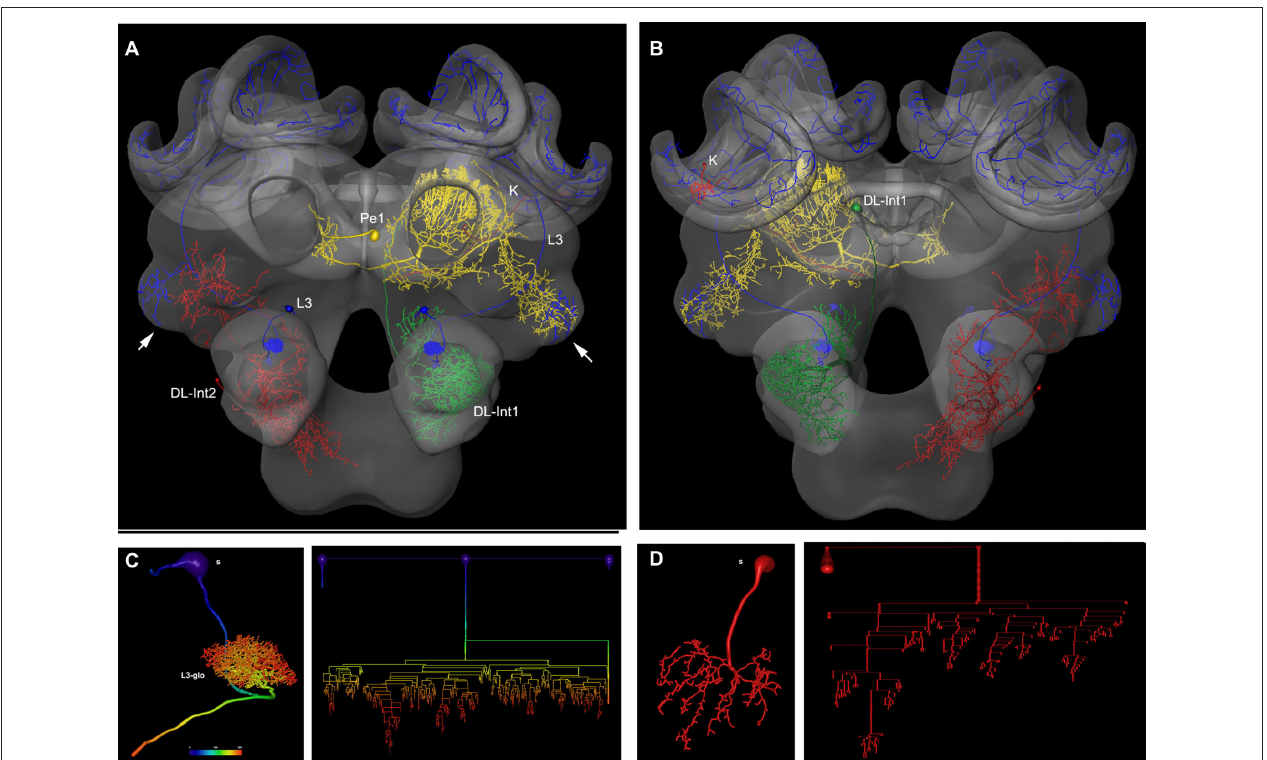
body calyces (MC, LC). The axonal terminals of the L3 neuron form microdomains in the lip region of the calyces and overlap with the dendritic fields of Kenyon cells (K, in B). Scale: 50 μm. (C, D) Neuron reconstruction and dendrogram of the respective neurons derived from high-resolution confocal scans. In (C) the neuronal distance is indicated in color. See false-color coded bar. (see also movies of supplementary material